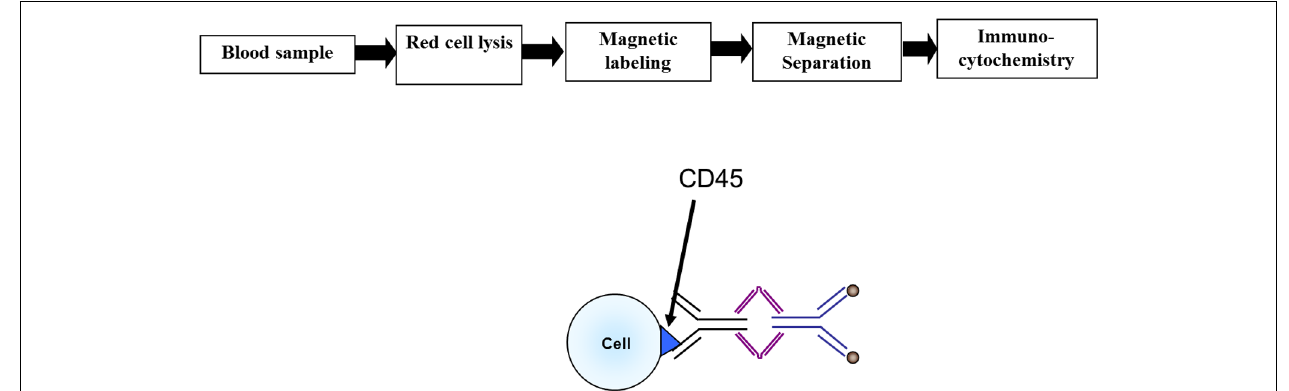
FIGURE 1 | Flow chart of the CTC enrichment methodology.